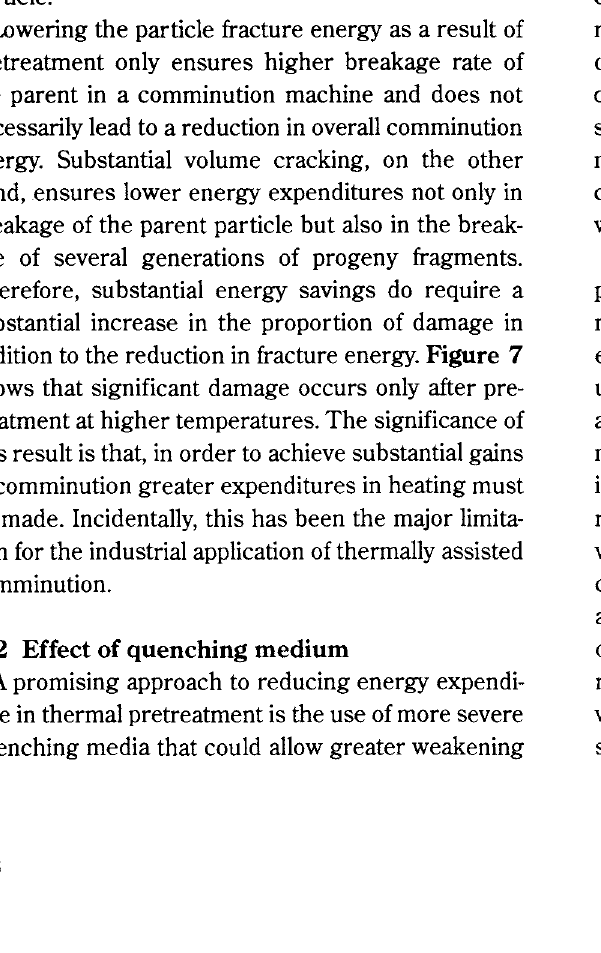
Fig. 8 Effect of quenching medium on the fracture characteris tics of 4.0-4.75 mm quartz. at lower temperatures. Several quenching media